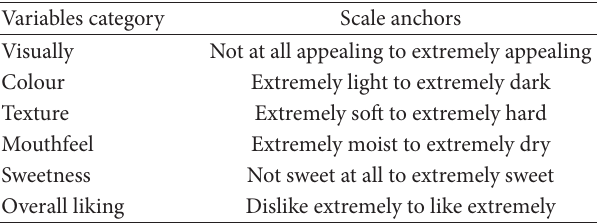
Table 2: Description of the scale anchors used from left side to right